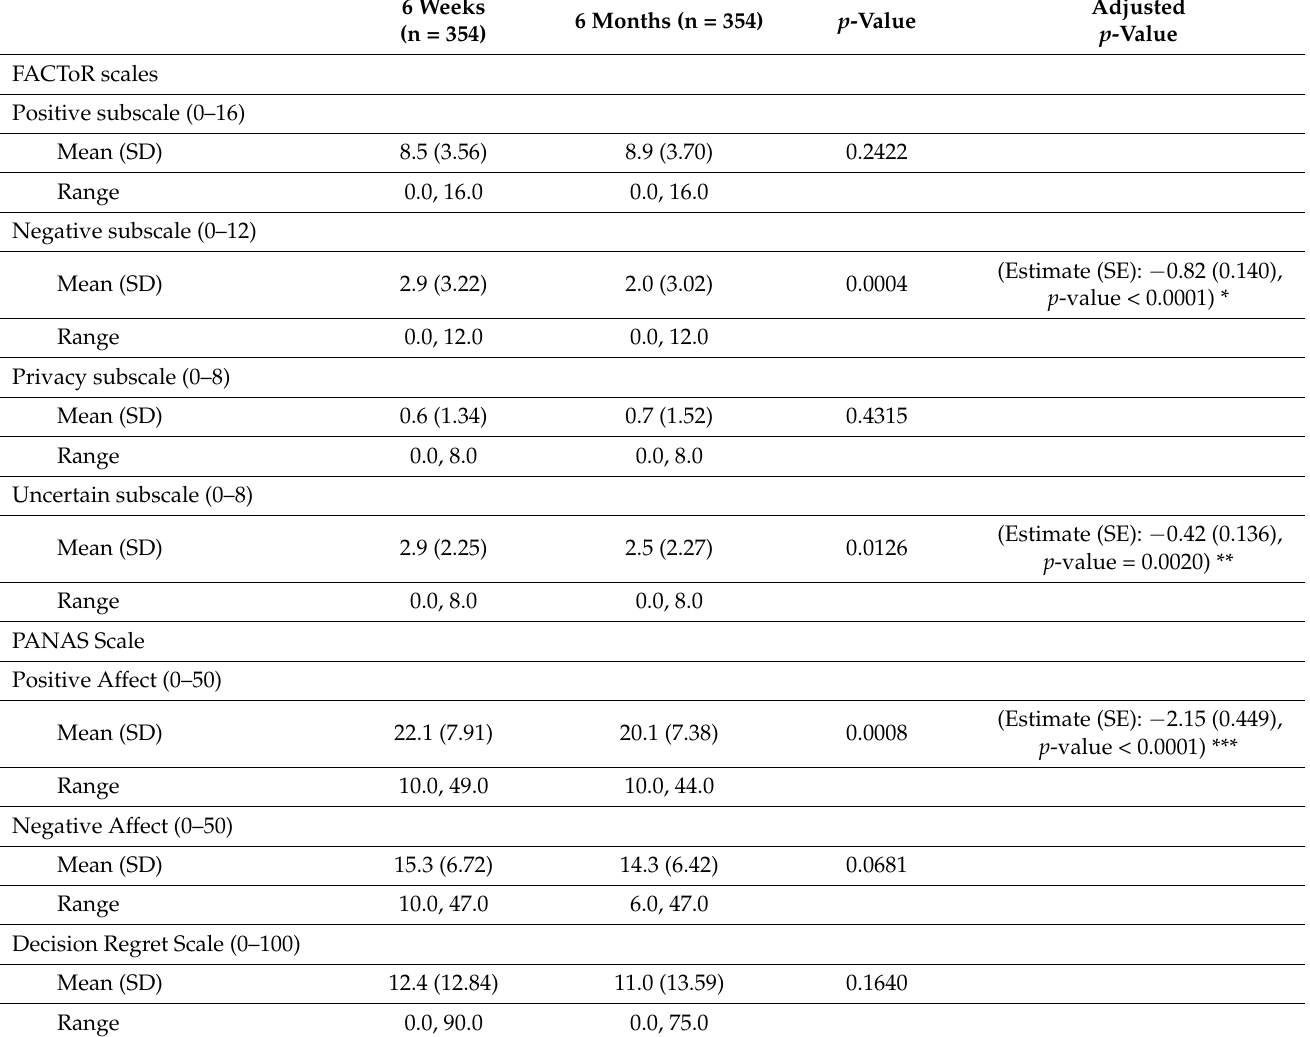
Table 2. Descriptive Statistics and Generalized linear models assessing relationship between time and